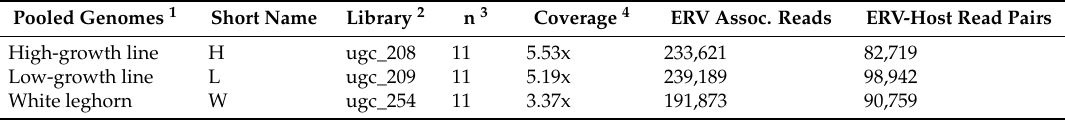
Table 1. Re-sequenced chicken selection lines and endogenous retrovirus (ERV) associated reads. Pooled Genomes 1 Short